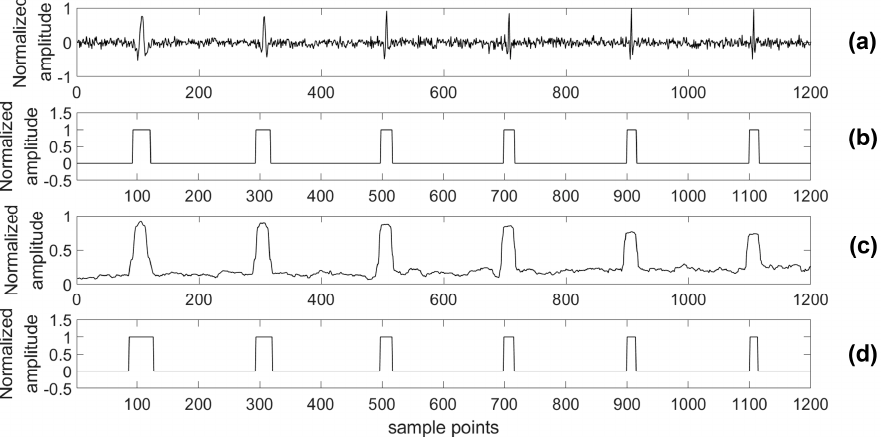
Figure 14. Channel A of test data ( − 5 dB) and its results. ( a ) Test data ( − 5 dB); ( b ) Detection results of the proposed algorithm; ( c ) Detection results of the STA/LTA algorithm; ( d ) The real label.